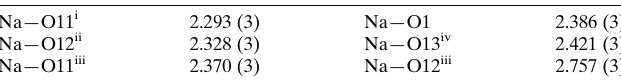
Table 2 Selected bond lengths (A˚ ).